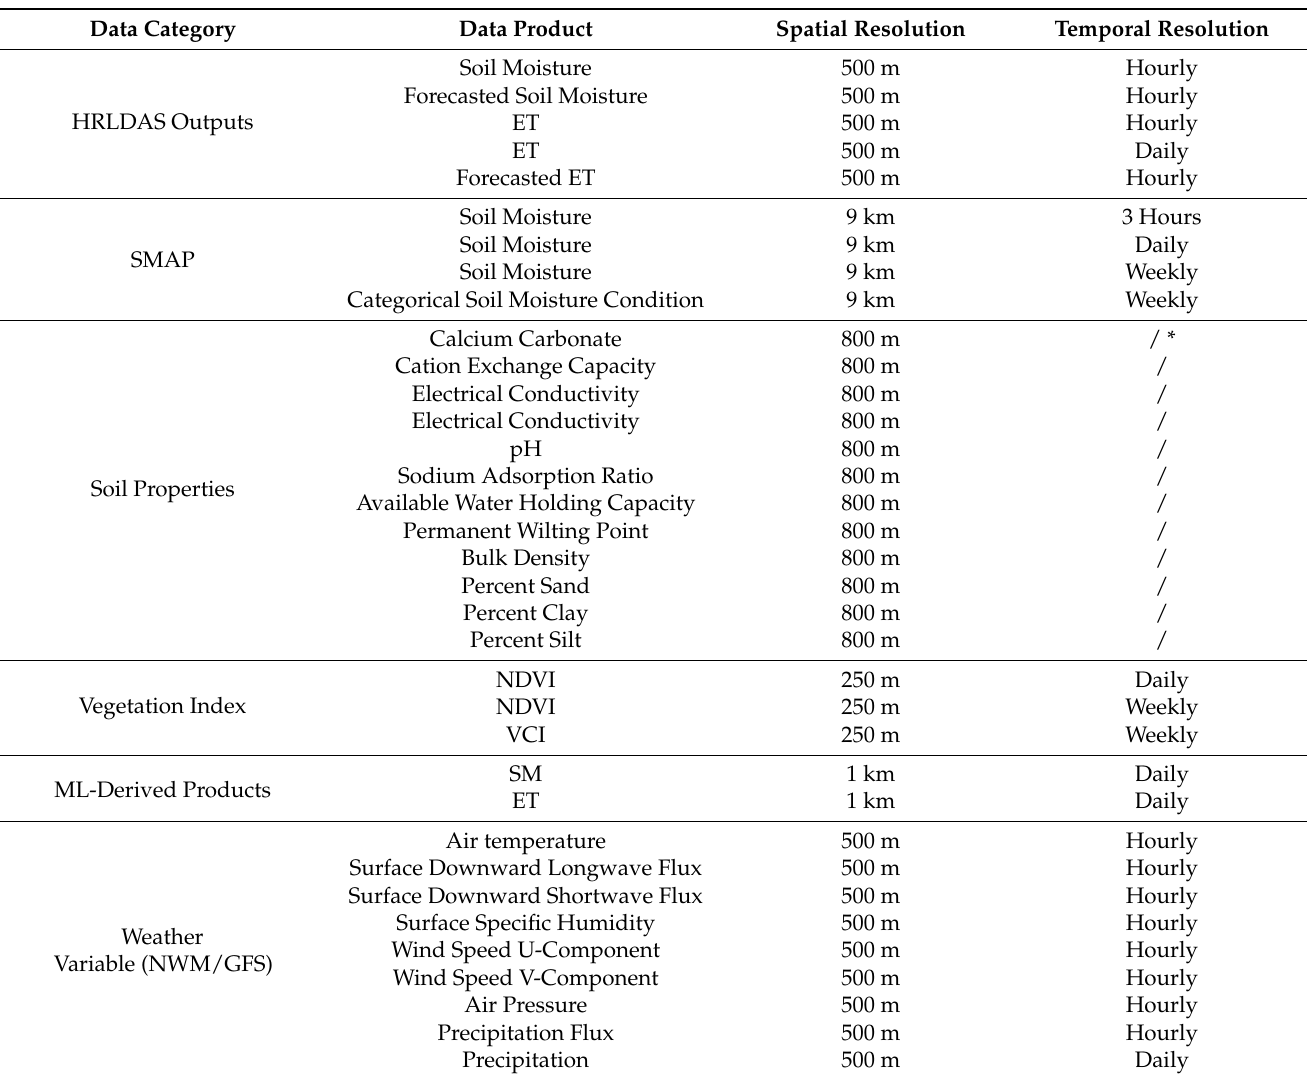
Table 1. Resolution specifications of the five categories of products and weather